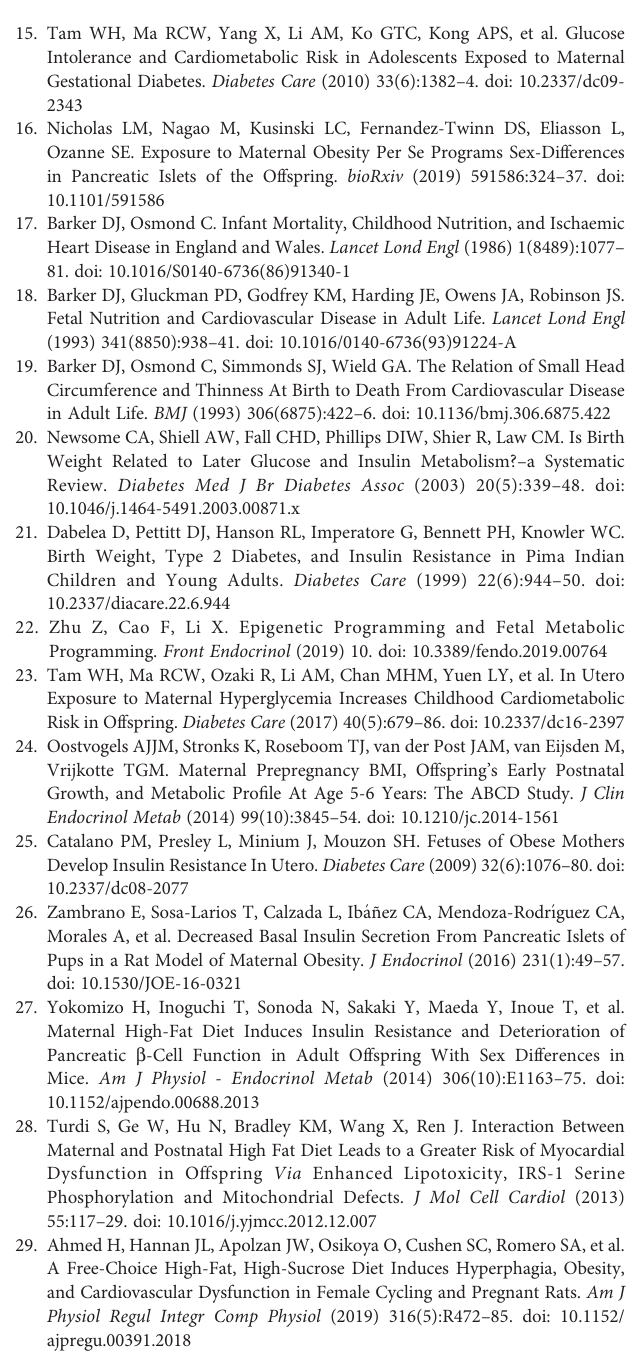
Supplemental Table 1 | Table 1 showing composition of macronutrients in % weight. Supplemental Table 2 | Table 2 showing percentage (%w/w) of HSG Disaccharides in pancreas collected from P21 offspring measured using